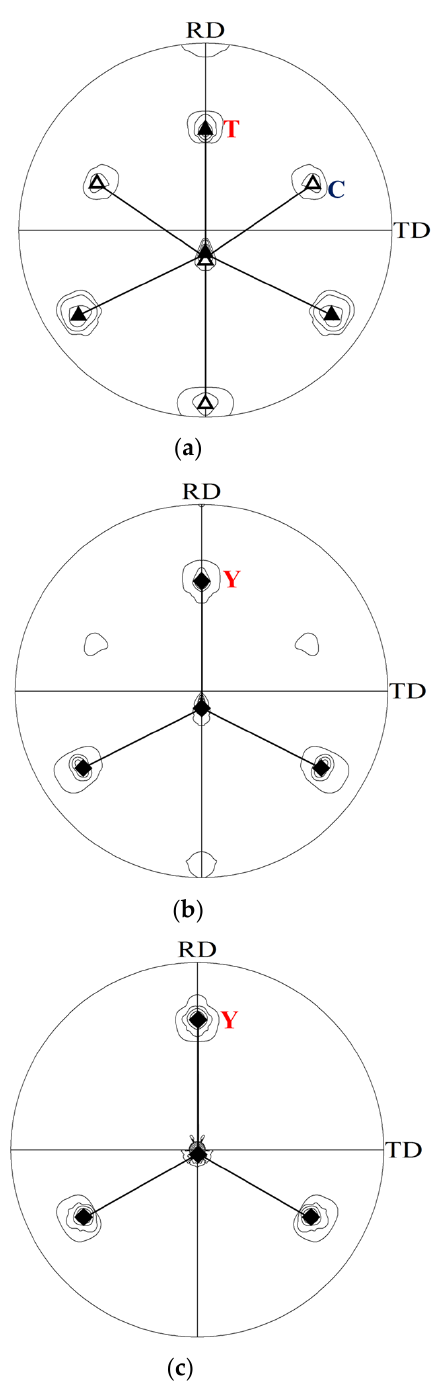
Figure 7. The {1 1 1} pole figures of fcc metals simulated using MTCS-model with single C orienta- tion after the reduction ratios of ( a ) 30%, ( b ) 60%, and ( c ) 90%. △ , ▲ , and ◆ are the pole positions on {1 1 1} pole figure of the orientation close to C (1 1 2)[1(cid:3364) 1(cid:3364) 1] , T (5 5 2)[1 1 5(cid:3364)] , and Y (1 1 1)[1 1 2(cid:3364)] , respectively.